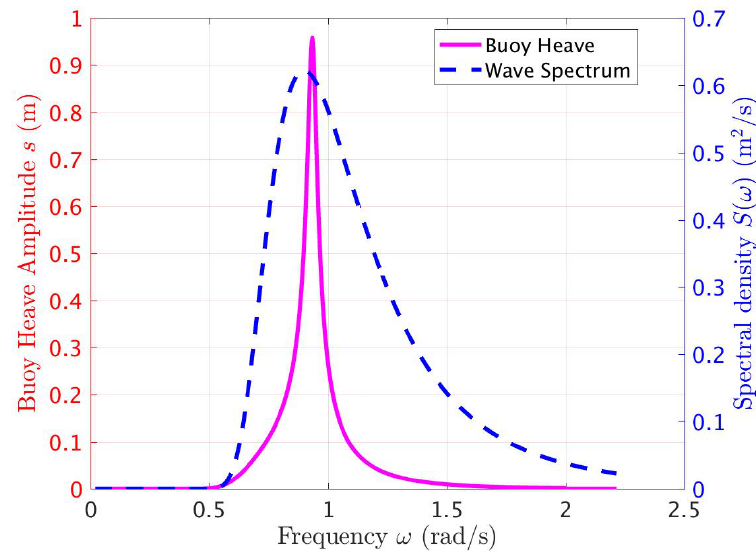
Figure 9. Buoy heave amplitude response to an irregular wave spectrum (Pierson-Moskowitz, H s = 1.0m, T e = 5.0s.) with beams fitting loosely within their deck supports. Also shown is the power spectral density.